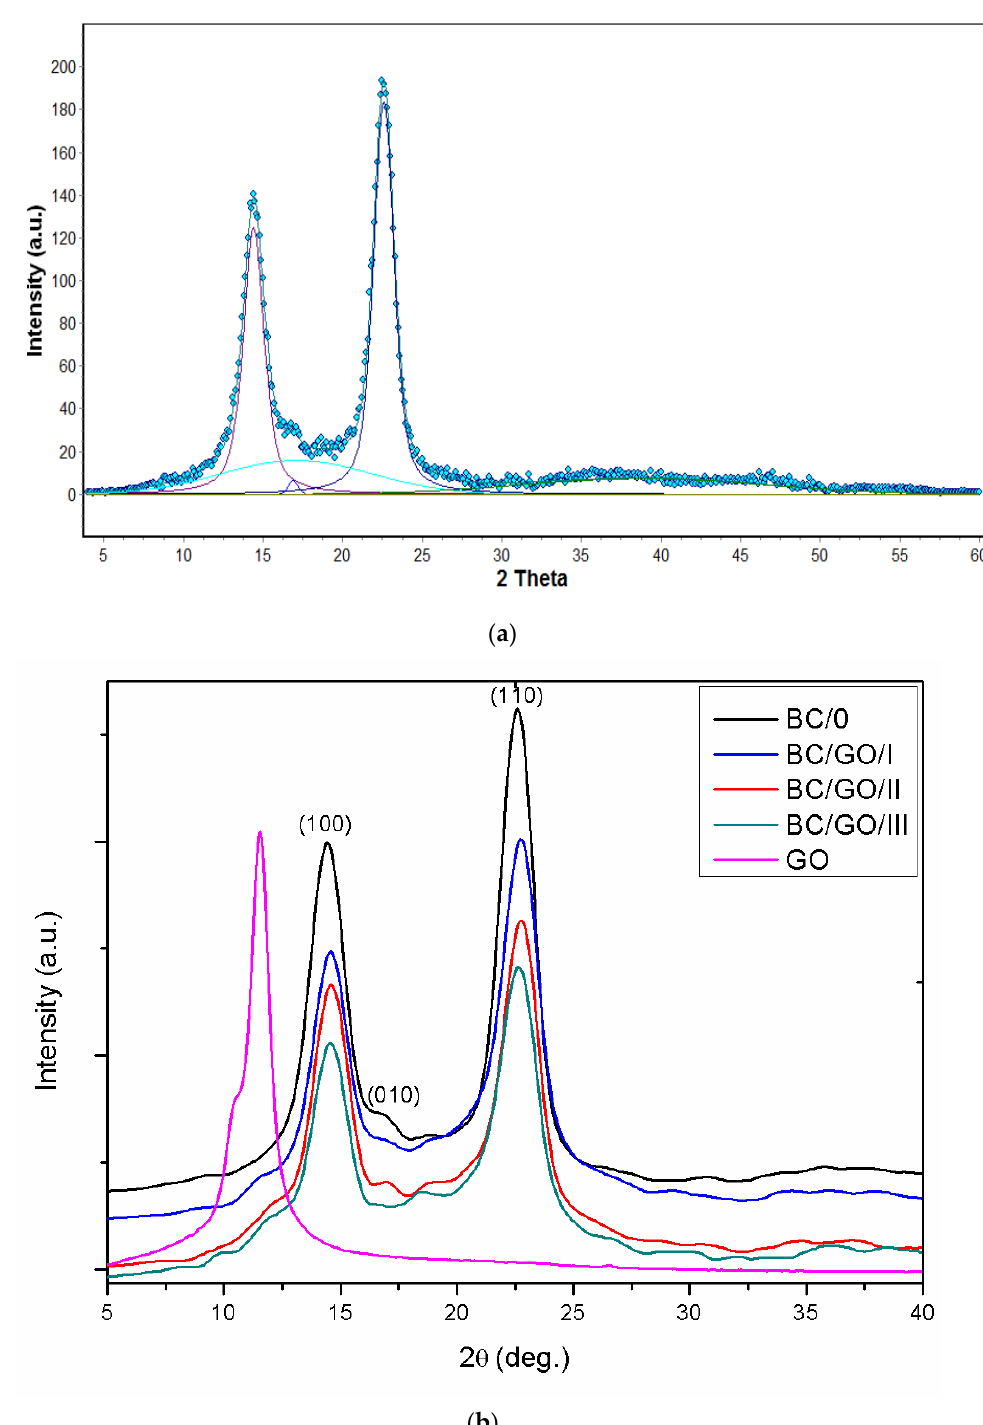
Figure 9. ( a ) Distribution of XRD diffraction patterns into crystalline and amorphous components; ( b ) Summary of diffractograms of pure BC (BC/0) and composites (BC/GO/I, BC/GO/II, BC/GO/III) as well as pure GO membranes.